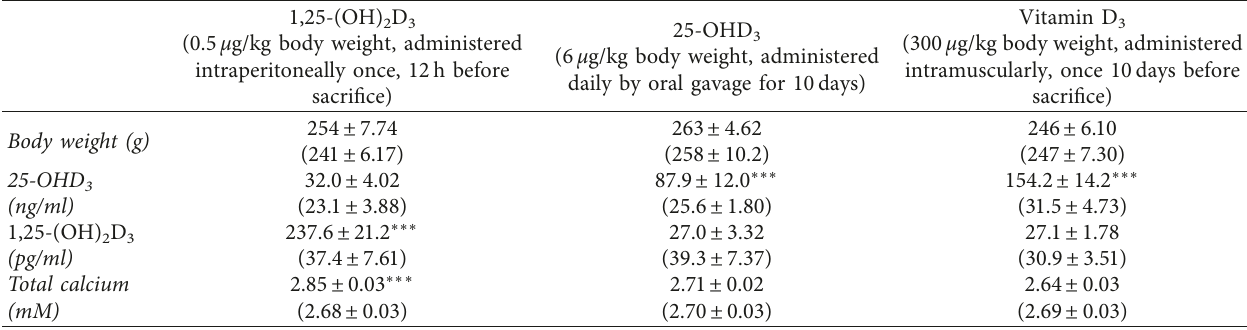
Table 2: Body weight and serum parameters of rats treated with different vitamin D metabolites.